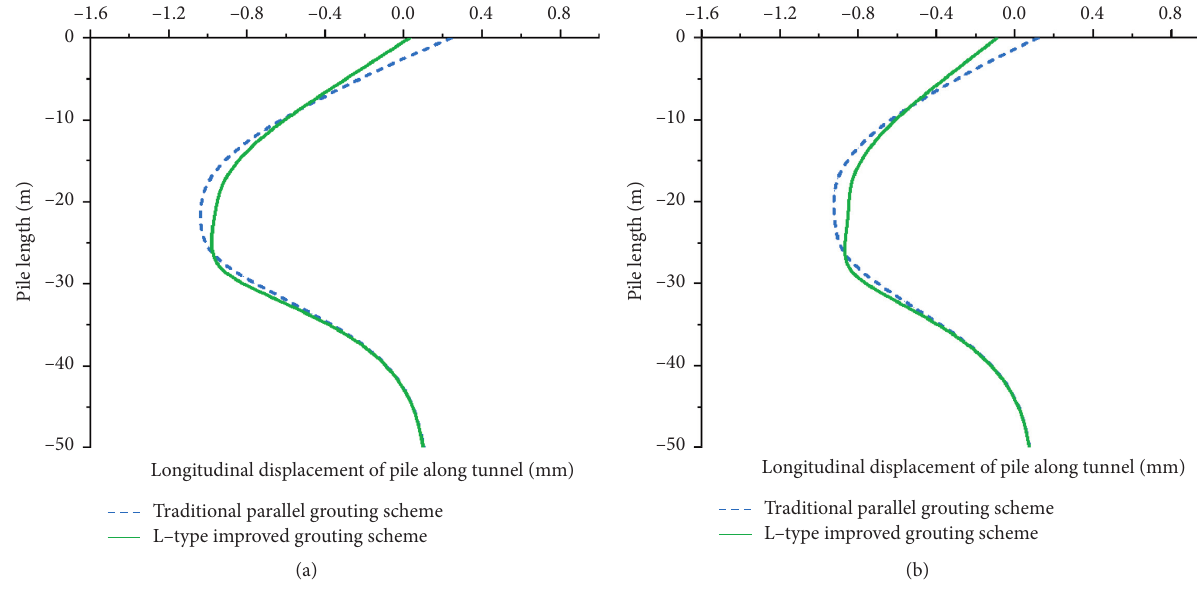
Figure 24: Longitudinal displacement of the pile along tunnel: (a) 6 rings after passing the pile; (b) 8 rings after passing the